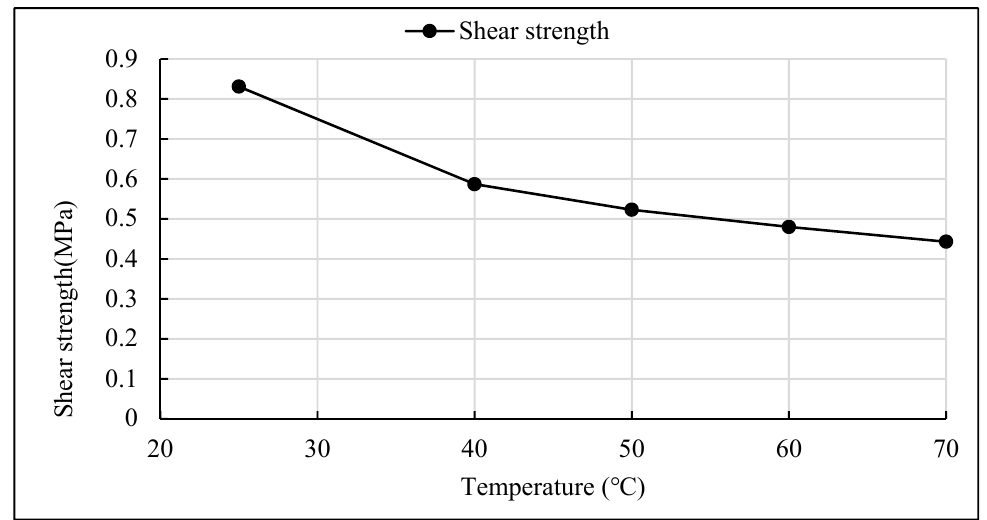
Figure 10. Relation of interlaminar shear strength with temperature.